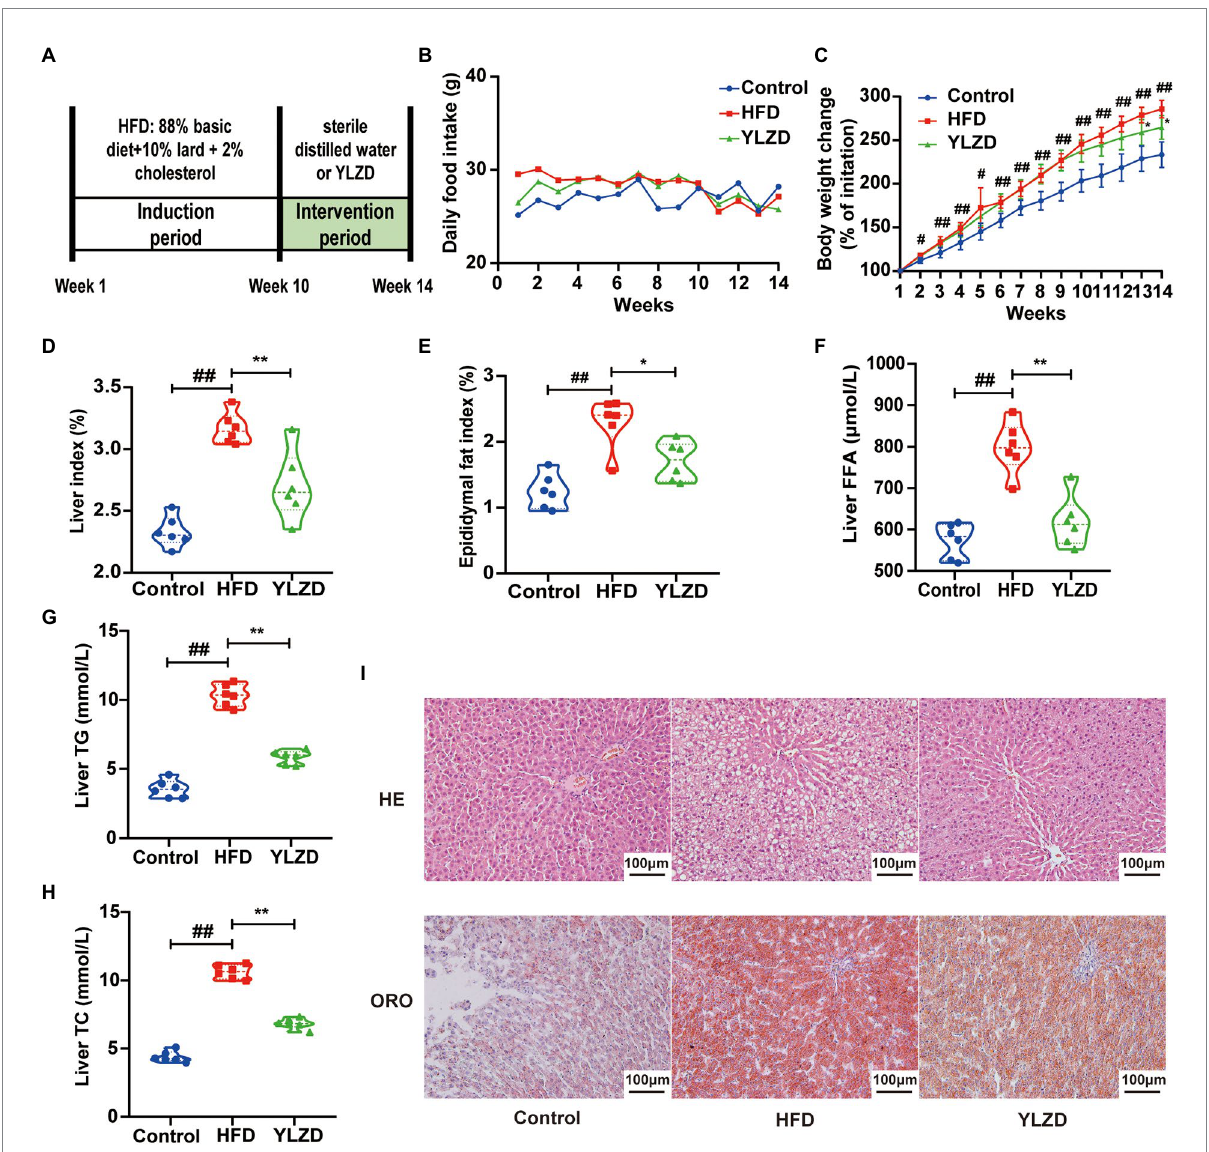
FIGURE 1 YLZD improved the general status and mitigated hepatic lipid deposition. (A) Experimental design, (B) daily food intake, (C) body weight change, (D) Liver index = Liver weight/Body weight × 100, (E) Epididymal fat index = Epididymal fat weight/Body weight × 100, (F–H) The level of liver FFA, TG and TC, respectively, and (I) Representative images of HE and oil red staining livers (magnification, ×200). Control group, normal rats treated with distilled water; HFD group, HFD-induced liver injury rats treated with distilled water; YLZD group, HFD induced liver-damaged rats treated with YLZD 1.92 g/kg/day for 4 weeks. Values are represented as mean ± SEM ( n = 6 rats/group). ## p < 0.01, # p < 0.05 versus the Control group; ** p < 0.01, * p < 0.05 versus the HFD